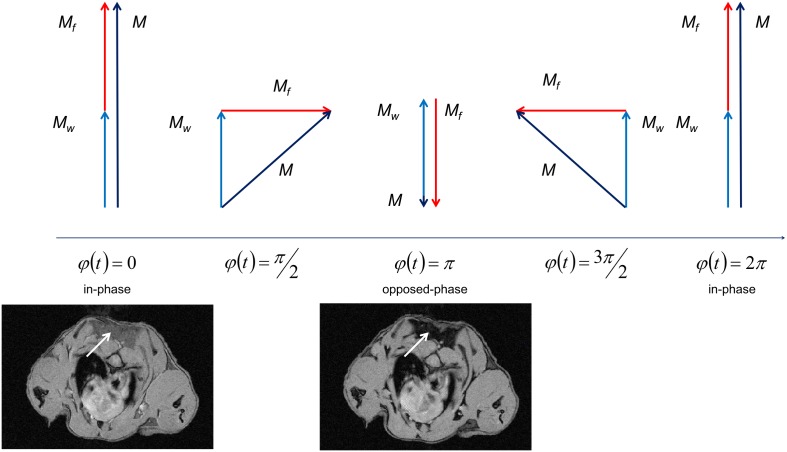
Resulting magnetization M (black) in a voxel containing almost equal concentration of water- (Mw, blue) and fat- (Mf , red) bond protons for different phase differences.Respective MR images of the mouse neck in axial orientation are exemplarily shown for in-phase (left) and opposed-phase (right) condition. The reduction of signal intensity in the interscapular BAT (arrows) is clearly appreciable.